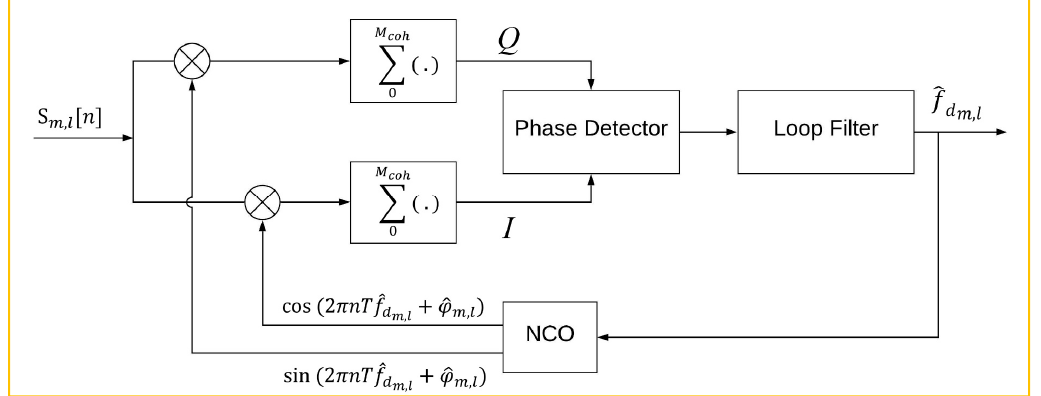
Figure 5. Architecture of proposed multi-constellation LEO satellite receiver.